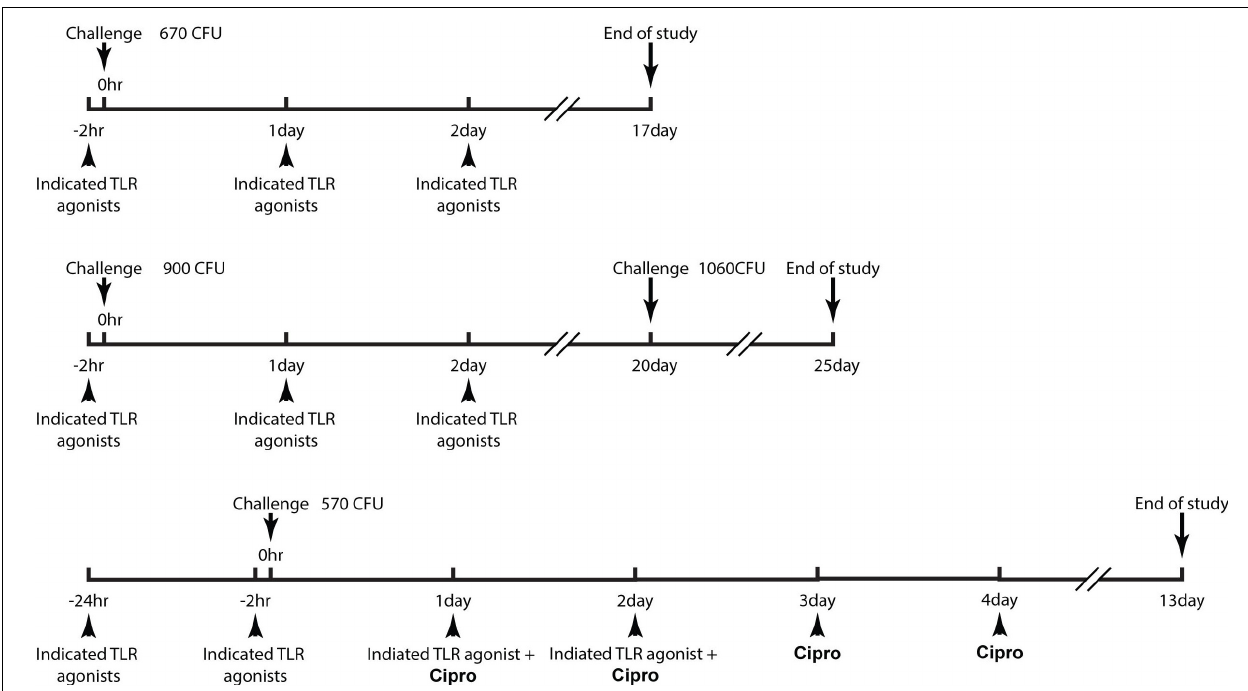
Frontiers in Microbiology |